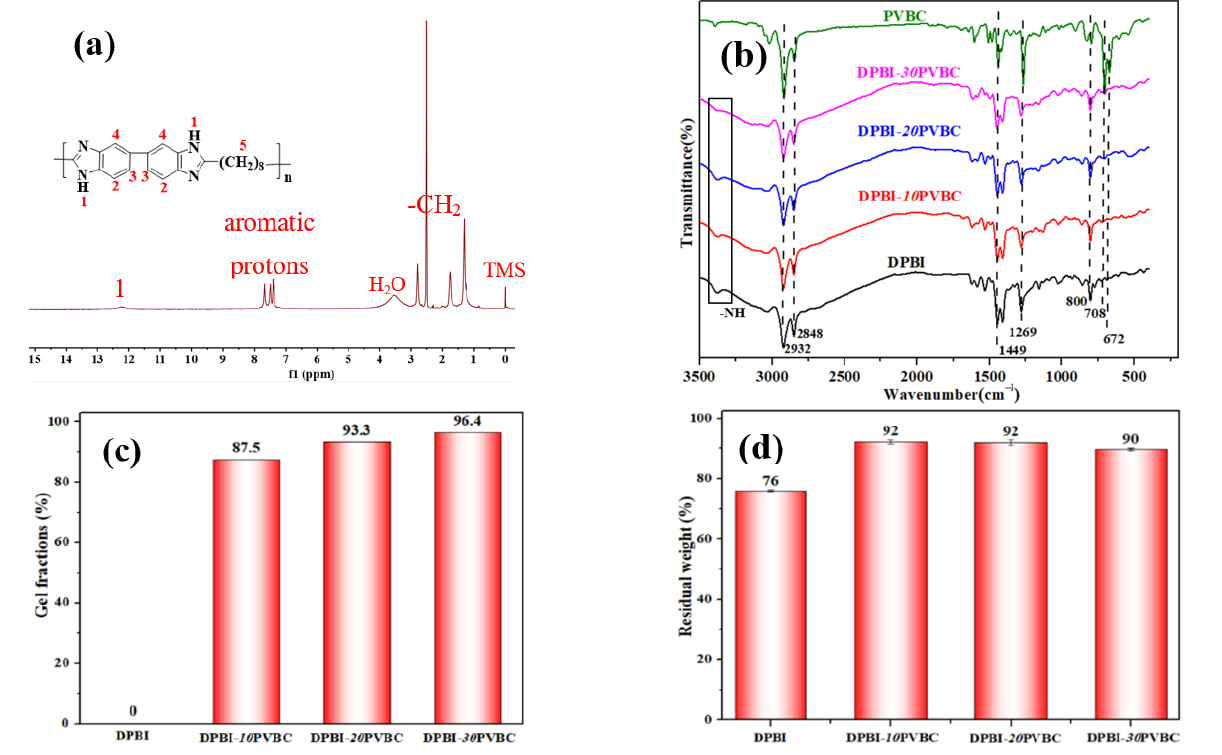
Figure 1. ( a ) 1H NMR spectra of DPBI in DMSO- d 6, ( b ) IR spectroscopy, ( c ) gel fractions, ( d ) oxidative of DPBI and DPBI- x PVBC membranes.